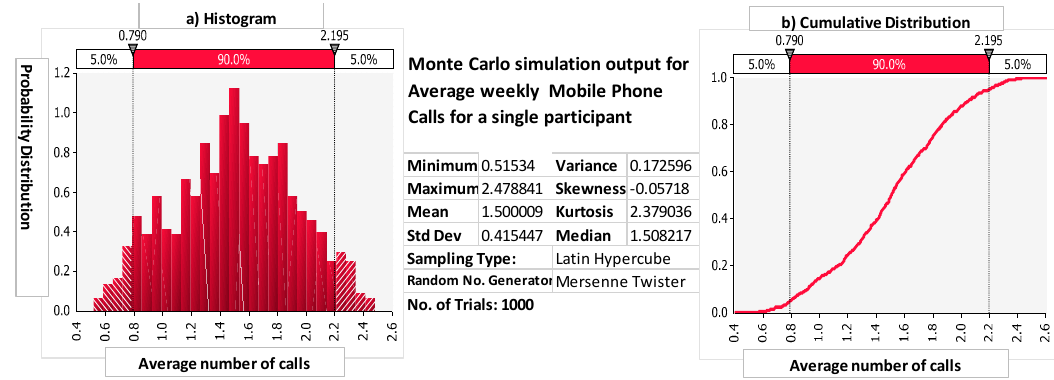
Figure 1. ( a ) Monte Carlo simulation for the average number of mobile phone calls after 1000 trials for an individual participant. Depicted is the histogram, plotting the probability distribution ( y -axis) vs. average weekly mobile phone calls ( x -axis) after n = 1000 trials, and ( b ) cumulative distribution showing risk probability vs. average weekly mobile calls.